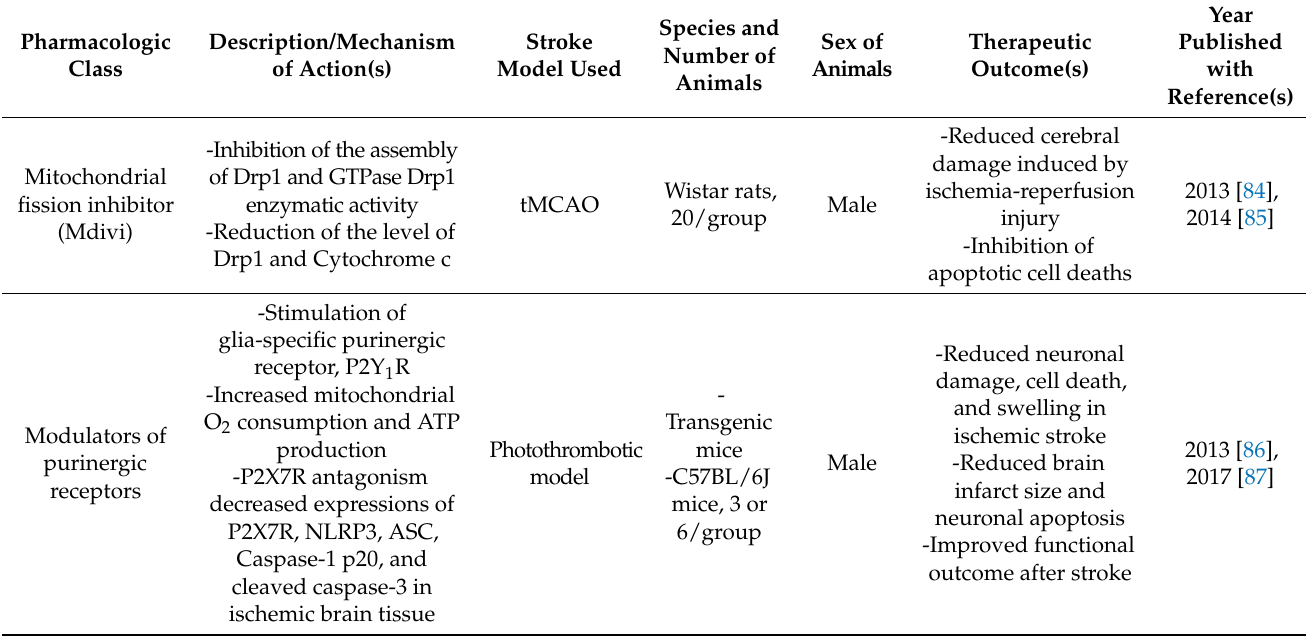
Table 1. Targeting mitochondria for regenerative therapy in ischemic